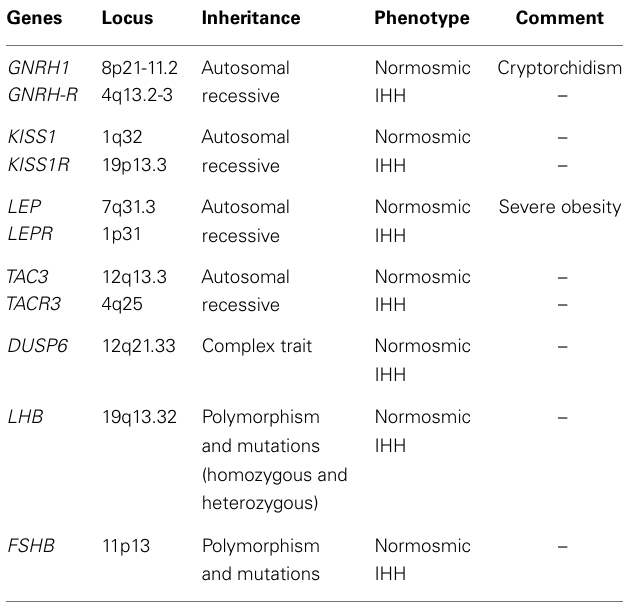
Table 1 | Genes and phenotype related only with normosmic IHH